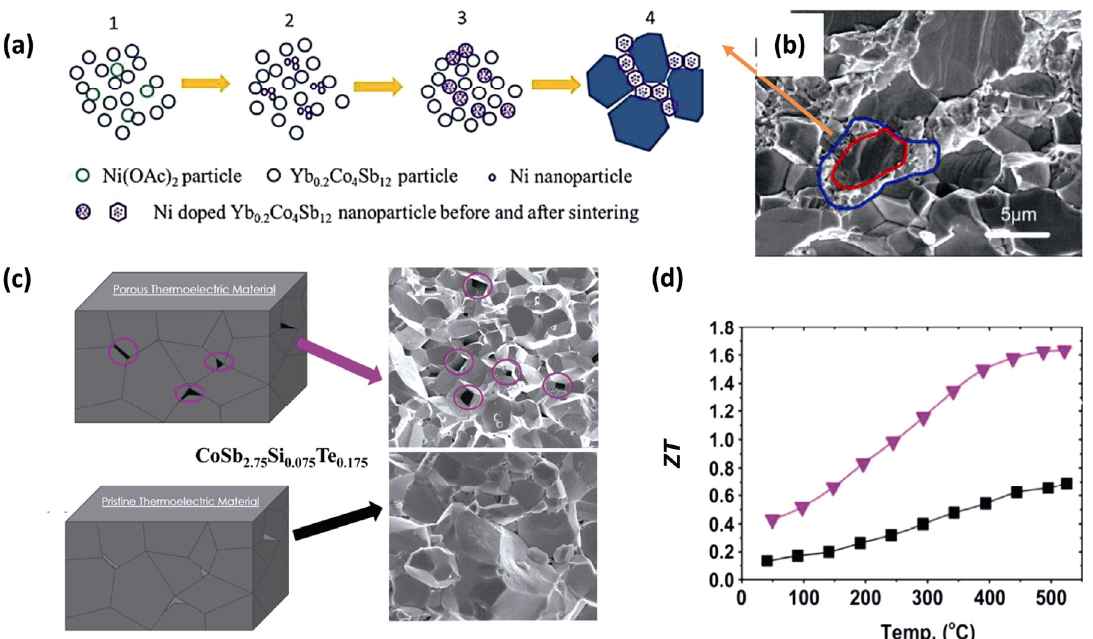
Fig. 9 CoSb 3 -based materials with special structure. (a) A sketch map for the whole forming process of the “core–shell” structure in Yb 0.2 Co 4 Sb 12 + x wt%Ni samples. The large blue polygons represent the normal Yb 0.2 Co 4 Sb 12 grains in the sintered bulk materials. (b) SEM fractograph of the Yb 0.2 Co 4 Sb 12 +0.2wt%Ni samples. Reproduced with permission from Ref. [156], © The Royal Society of Chemistry 2015. (c) Schematic illustration and SEM fractographs of CoSb 2.75 Si 0.075 Te 0.175 material with pristine and porous; (d) temperature dependence of ZT values for CoSb 2.75 Si 0.075 Te 0.175 material with pristine and porous. Reproduced with permission from Ref. [157], © The Author(s)